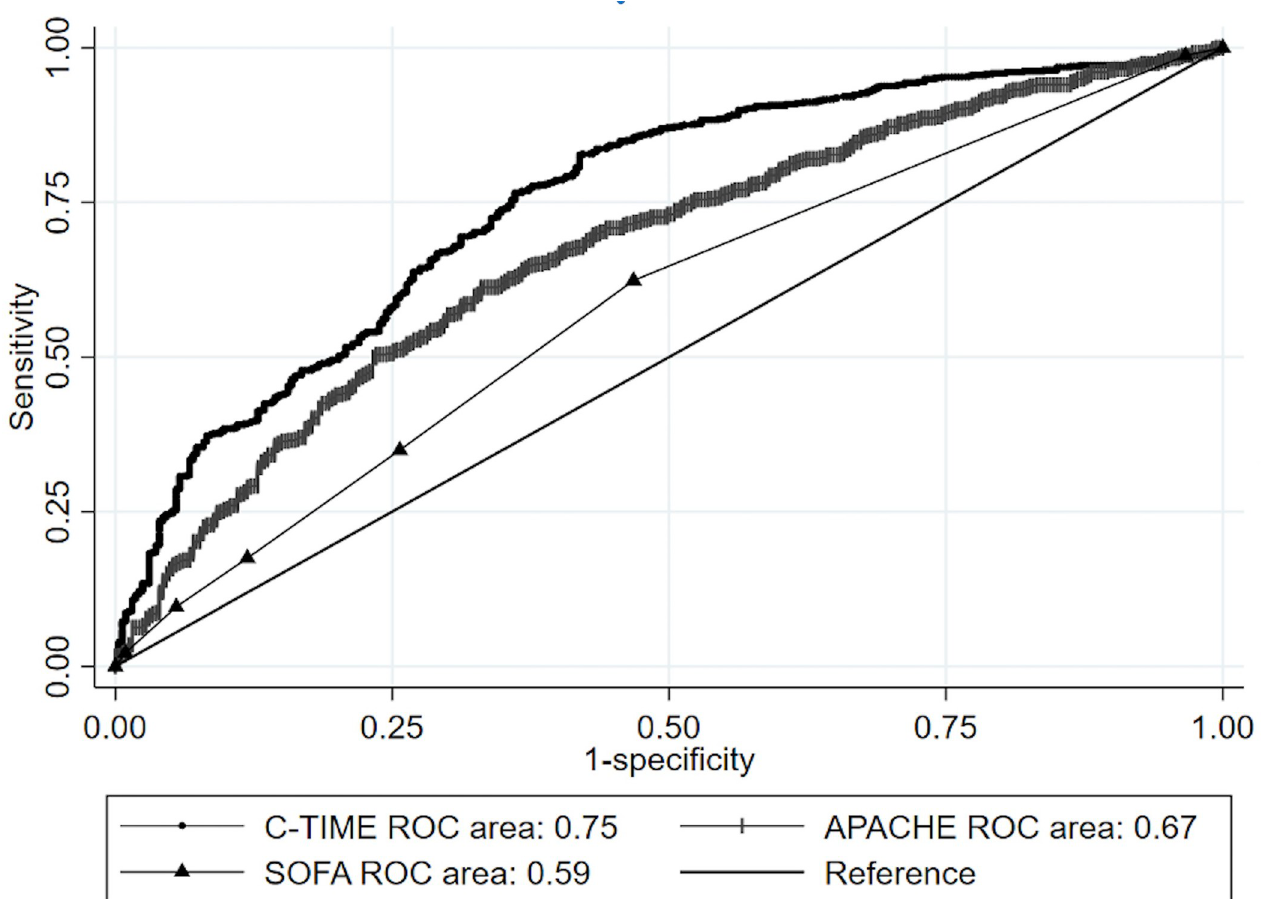
Fig 1. Comparative AUROC of C-TIME, APACHE IVa, and SOFA mortality prediction systems.